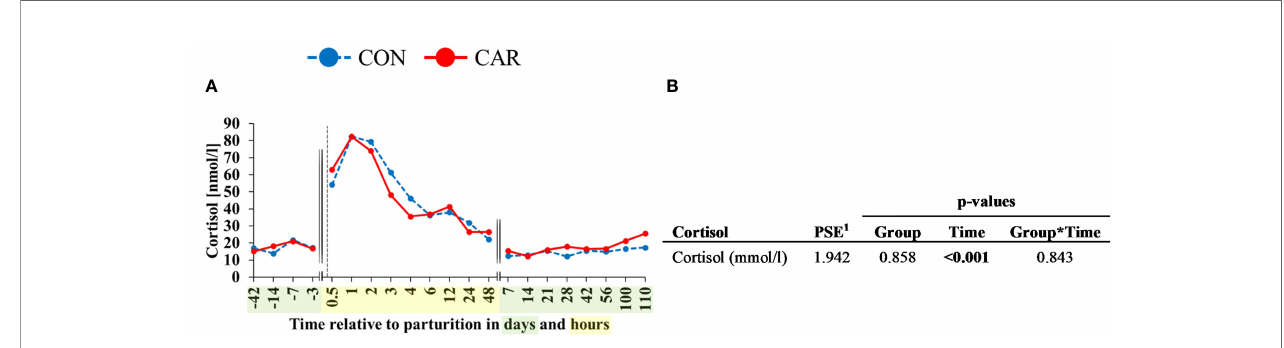
FIGURE 9 | (A) Effects of dietary L-carnitine on serum cortisol of dairy cows fed diet supplemented with (CAR) or without (CON) L-carnitine from 6 weeks before until 15 weeks after calving. (B) Data statistics. Data are shown as least square means. 1 pooled standard